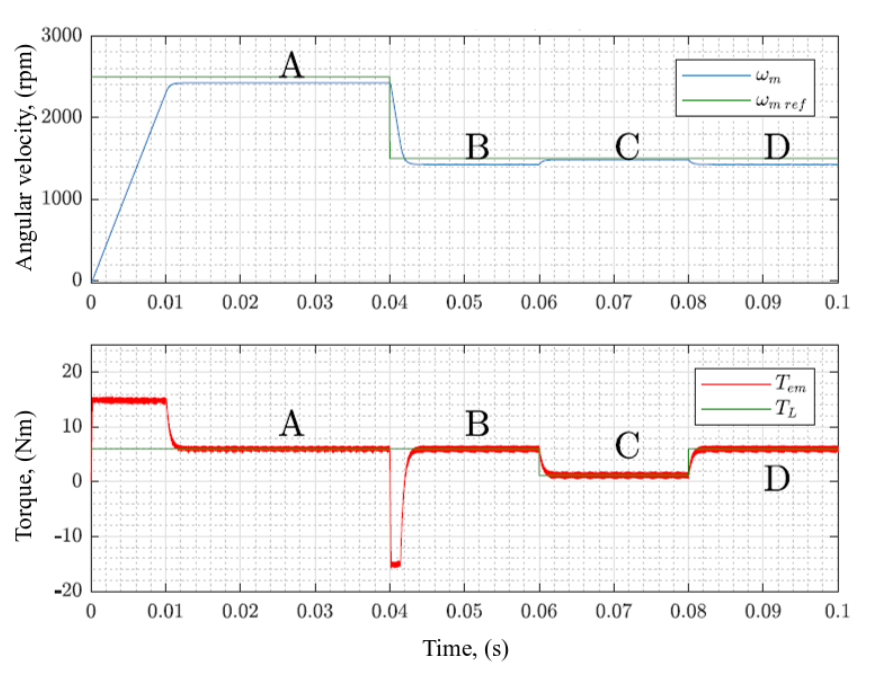
Figure 7. PI control loop, series configuration. Mechanical characteristics.